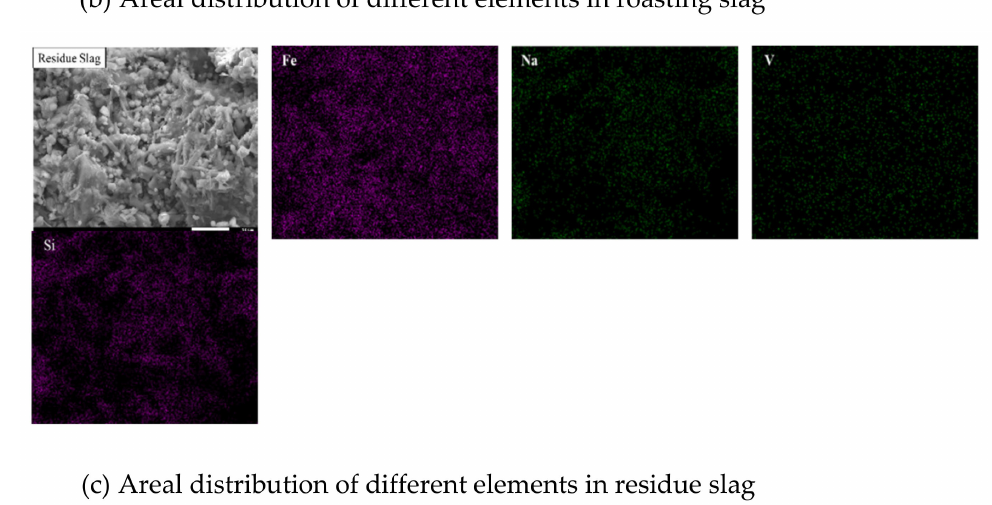
Figure 5. Microstructure and elements distribution of vanadium slag and during roasting and leaching. Figure 6 shows the X-ray photoelectron spectroscopy of vanadium slag, roasted slag, and residue samples (a) global XPS; (b) the valence change of V; and the valence change of Fe. It can be seen from Figure 6 that vanadium slag mainly contains Fe, Mn, V, Si, O, Ca, and C elements; roasting slag mainly contains C, Na, O, V, Ca, C and Si, but Fe element peak is very small, this is because XPS is a surface analysis technique, the formed